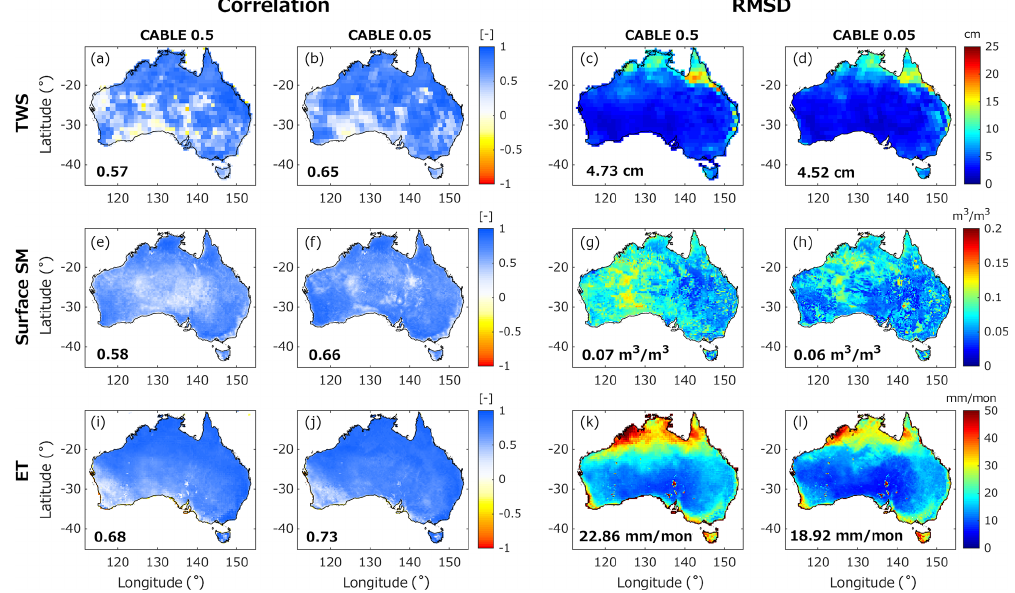
Figure 10. The comparison between CABLE 0.5 ◦ and CABLE 0.05 ◦ estimates and different remote sensing products in terms of correlation coefficient (a, b, f, i, j) and root mean square difference (RMSD; c, d, g, h, k, l ). The terrestrial water storage (TWS; a–d ), surface soil moisture (SSM; e–h ), and evapotranspiration (ET; i–l ) are compared with GRACE, ESA CCI, and GLEAM products, respectively. The averaged statistical values (over Australia) associated with each comparison are also given.